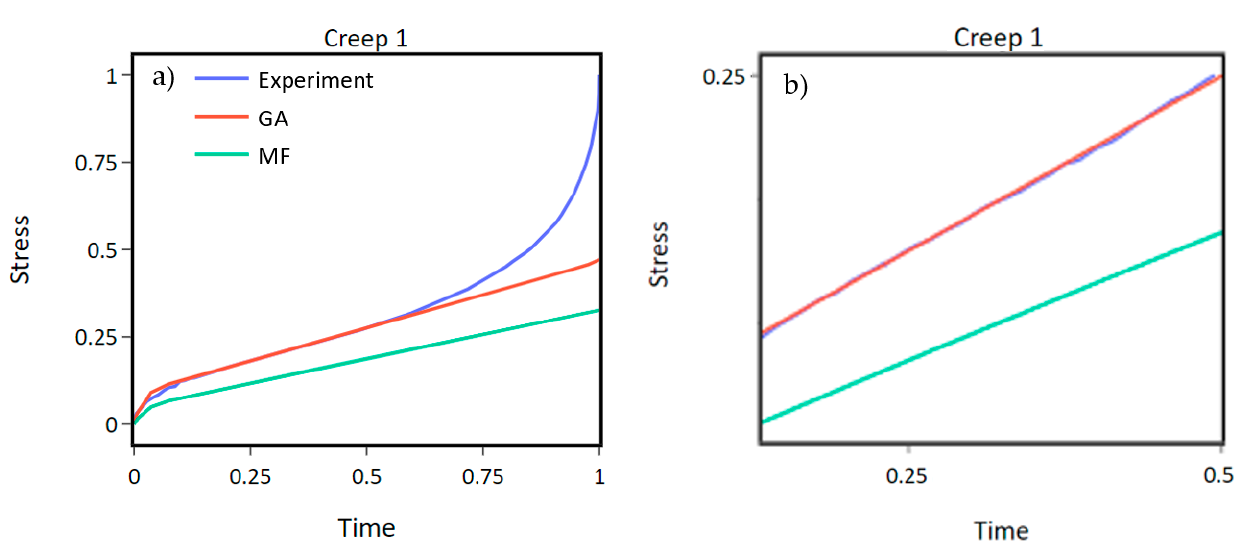
Figure 7. Impact of crossover operators on the GA’s performance. There is no significant difference between the two- and single-point crossovers.